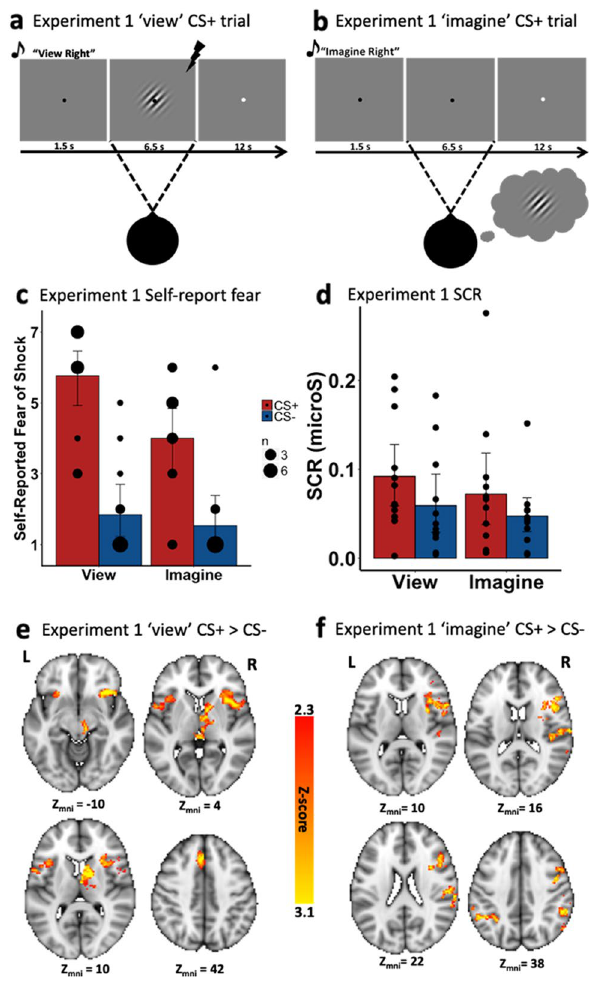
Figure 1. The trial sequence from Experiment 1 for ( a ) a ‘view’ CS+ trial and ( b ) an ‘imagine’ CS+ trial. ( c ) Self- reported fear of shock; and ( d ) SCR results. While Red bars denoted the CS+ and Blue bars represented the CS−. Error-bars represent 95% confidence intervals. Black dots represent individual data points. For the self-reported fear of shock data, the size of the circle represents the number of participants that endorsed a given response. Activation maps for ( e ) ‘view’ CS+ > ‘view’ CS−. Activation maps for ( f ) ‘imagine’ CS+ > ‘imagine’